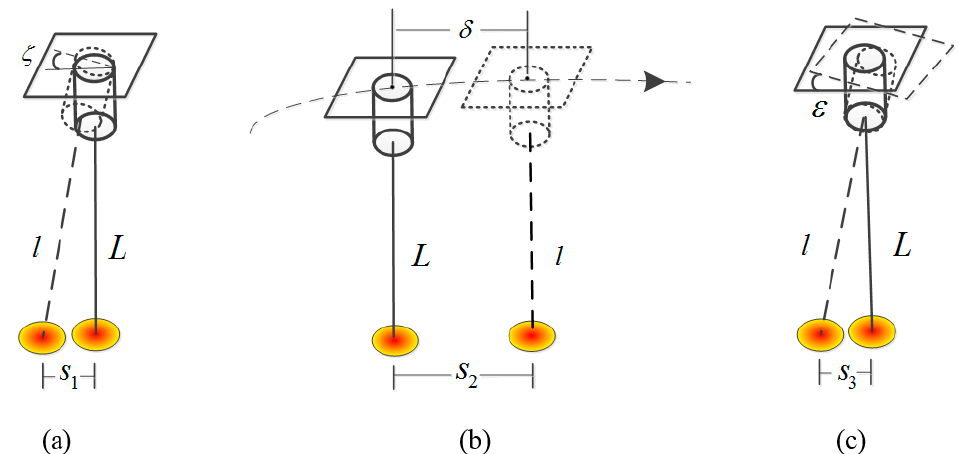
Figure 5. Decomposition of laser footprint prediction errors: ( a ) laser pointing errors; ( b ) orbit errors; and ( c ) attitude errors.